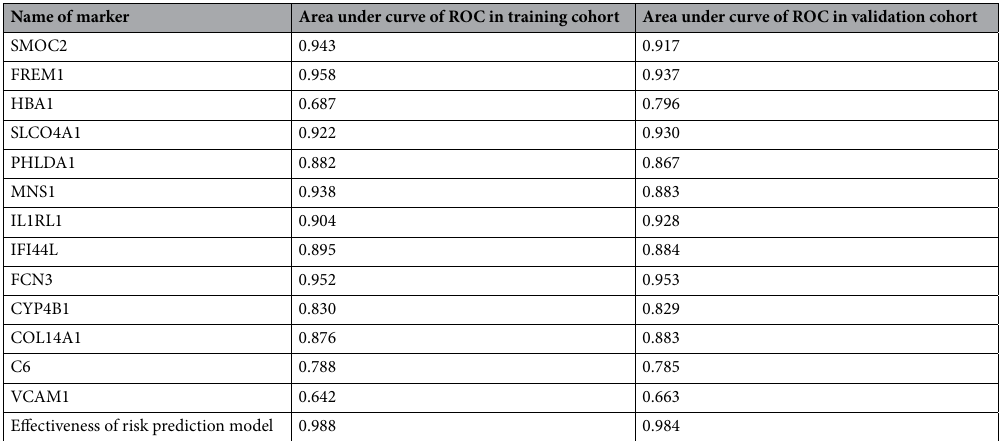
Name of marker Area under curve of ROC in training cohort Area under curve of ROC in validation